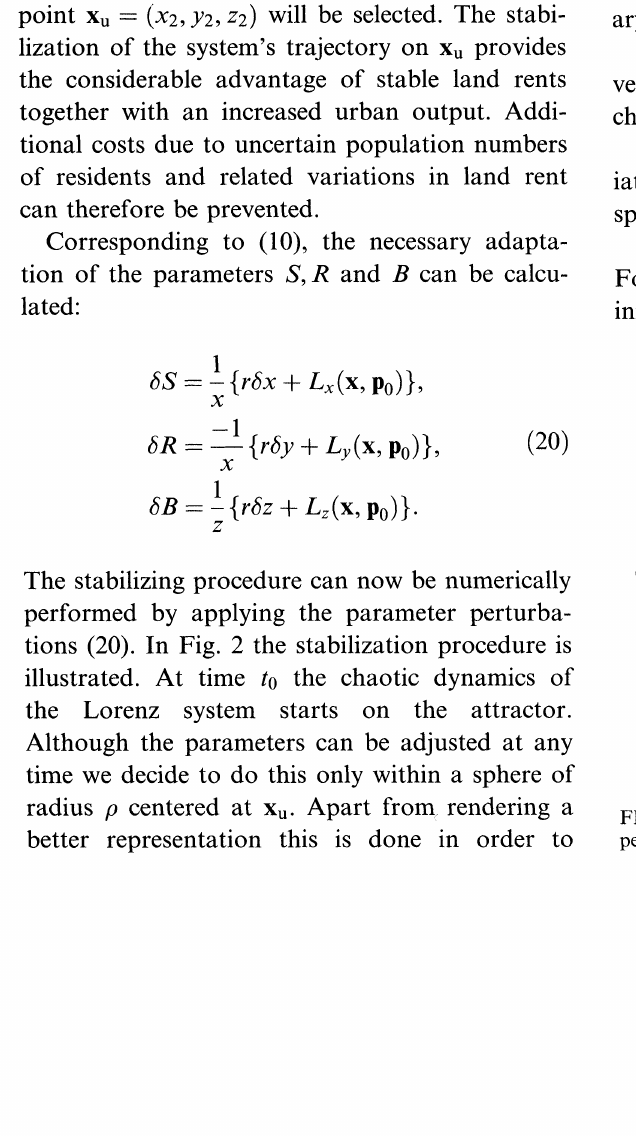
FIGURE Projection of the chaotic attractor into the (x, z)-plane. The asterisks mark the stationary points x2, x3. Those two symmetric unstable foci are placed in the centres of the two ’Lorenz lobes’ (see Fig. 1).